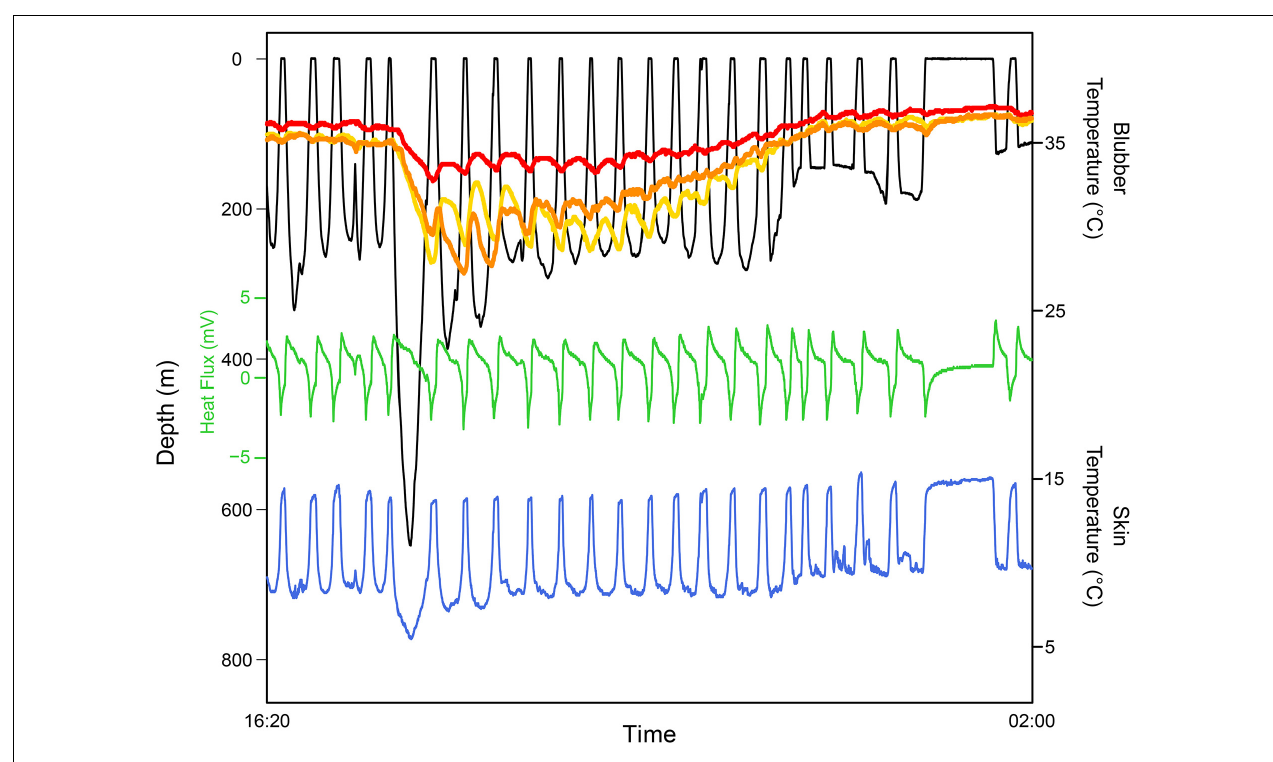
FIGURE 10 | An example of time series data from a freely diving juvenile Northern elephant seal, Mirounga angustirostris , over a short at-sea trip equipped with physiological biologgers that measure heat flux and body temperatures. The dive profile (black) shows a deep dive to > 600 m followed by an extended surface interval many hours later. The heat flux profile (green)—shown in raw voltage units—indicates whether the seal is gaining ( < 0 mV) or losing heat ( > 0 mV). Skin temperature (blue) measured by a thermistor imbedded in the heat flux sensor remained near water temperature (not shown; measured by a thermistor on the satellite tag mounted on the seal’s head). Three thermistors inserted into the blubber layer (red, deep; orange, mid; yellow, shallow) show how the blubber temperature gradient changes with diving behavior, suggesting changes in peripheral perfusion (Favilla,